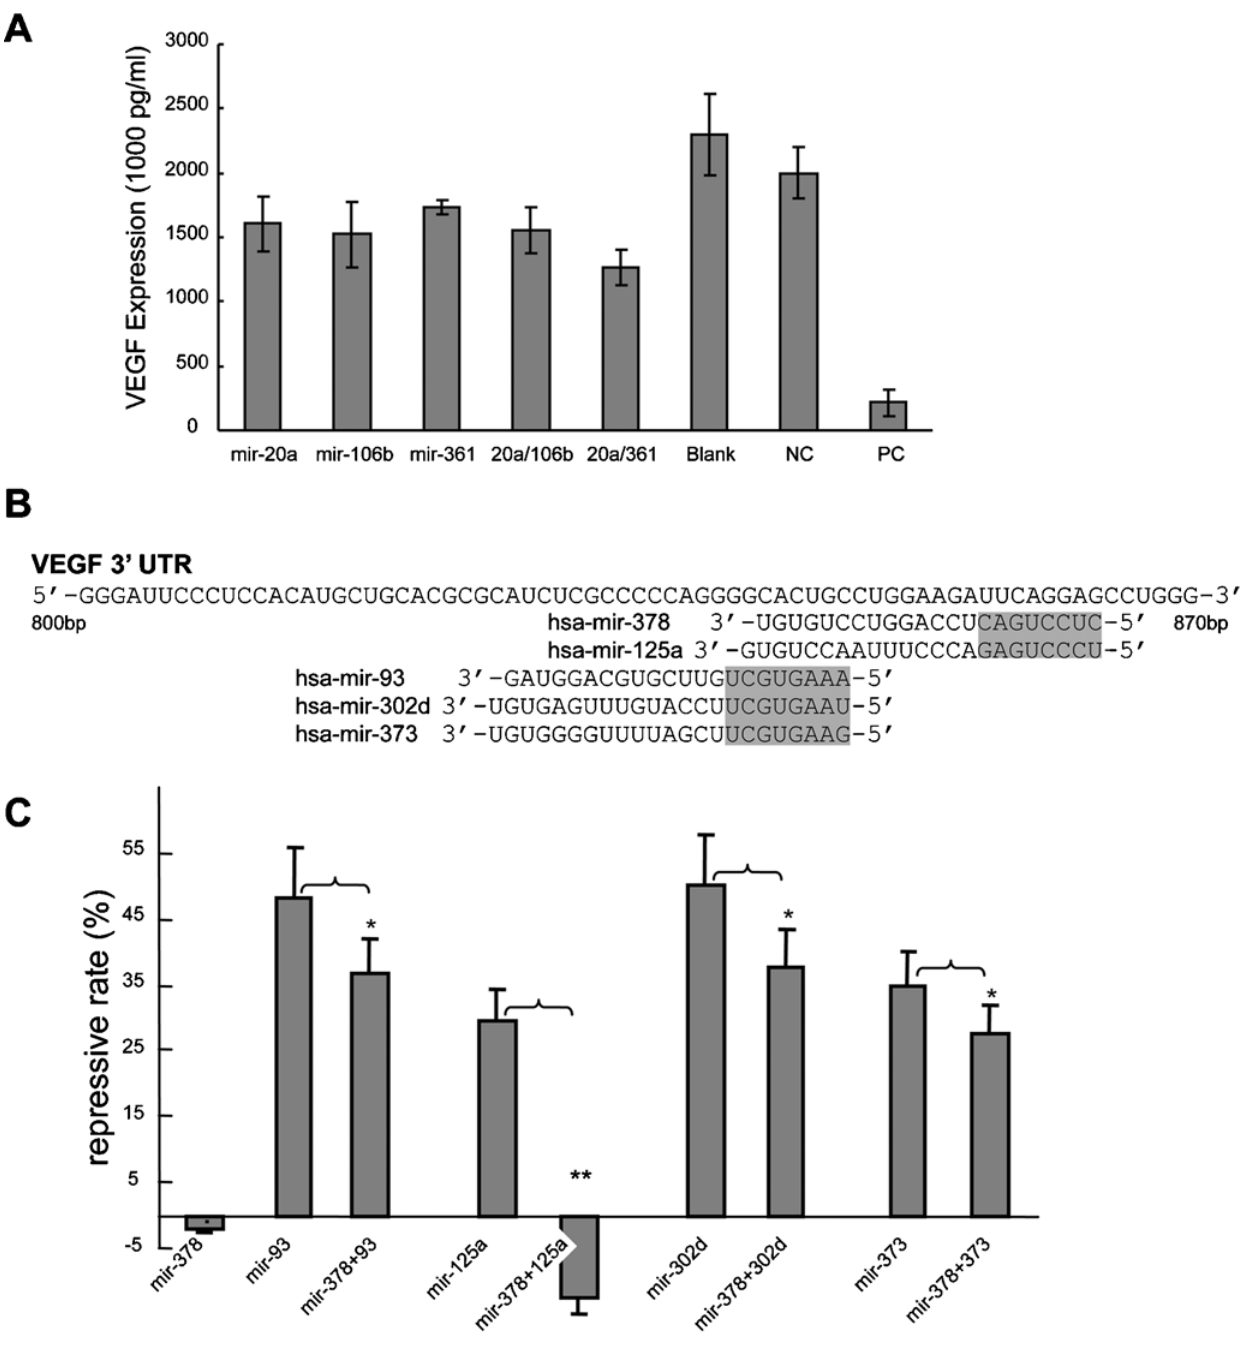
Figure 5. Effects of different combinations of miRNAs on VEGF expression. (A) CNE cells were transfected or co-transfected with miR-20a and miR- 106b , which share the same binding site, or with miR-20a and miR-361 , which target different binding sites. An unrelated random sequence was used as a negative control (NC). A specific sequence targeting VEGF (functioning as siRNA) was used as a positive control (PC). Culture medium was collected 30h after transfection. Repression of VEGF expression was detected by ELISA. (B) miRNA binding site locations of miR-378, miR-125a, miR-93, miR-302d , and miR-373 in the VEGF 3 9 -UTR fragment of Construct II. (C) COS-7 cells were co-transfected with (1) Construct II and miR-378, miR-125a, miR-93, miR-302d , or miR-373 ; (2) Construct II and miR-378 plus either miR-125a, miR-93, miR-302d , or miR-373 . Luciferase activity was measured to investigate the effects of different combinations of miRNAs. *, p , 0.05; **, p , 0.01.